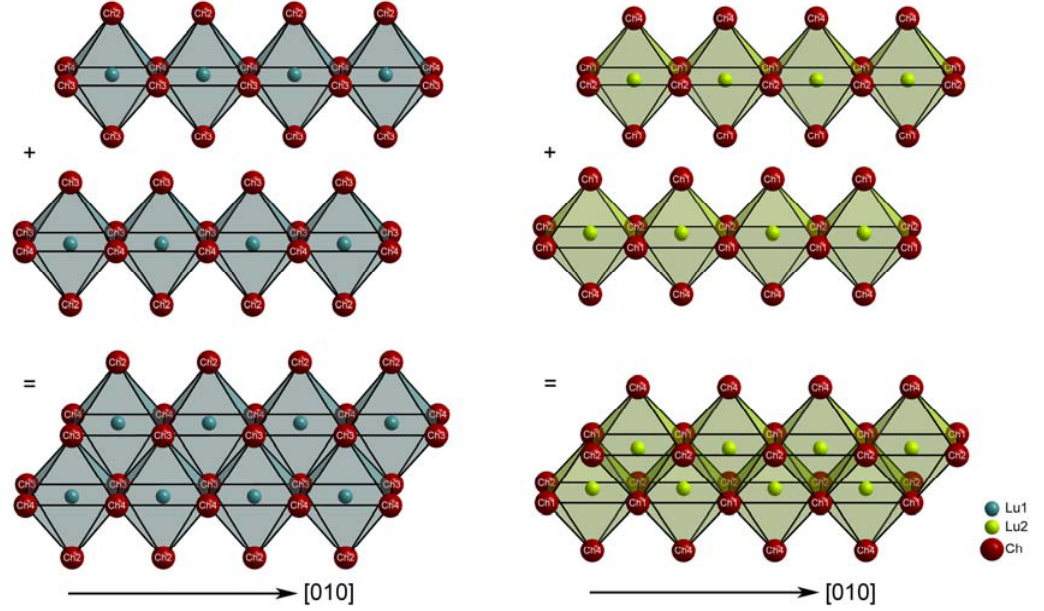
{[(Lu1) Ch e Ch t ] 8– } ( left ) and 1 44 / 22 /  Ch series ( Ch = S, Se and Te). 2 4